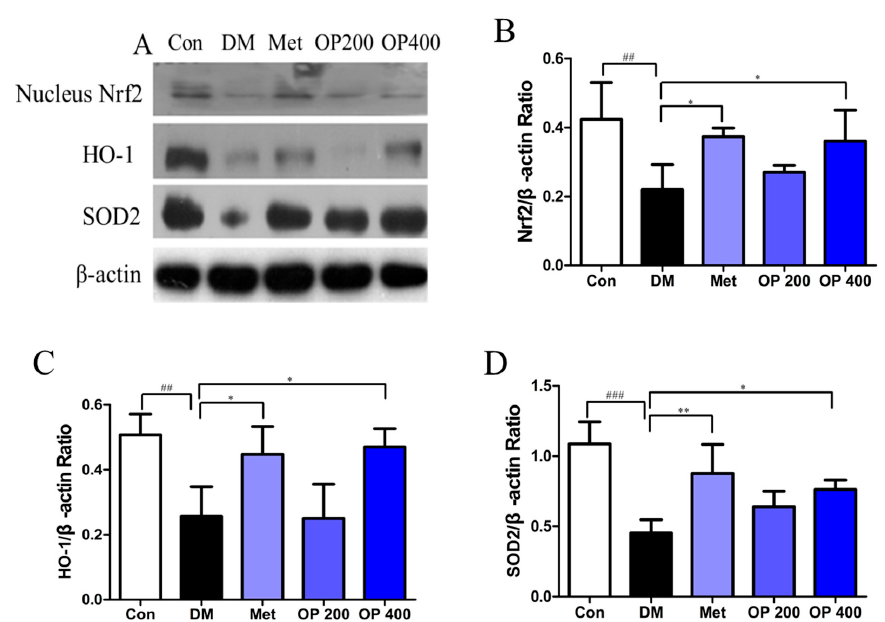
Figure 8. ( A ) Effect of OP on the expression of nuclear factor erythroid-2 (Nrf2), heme oxygenase-1